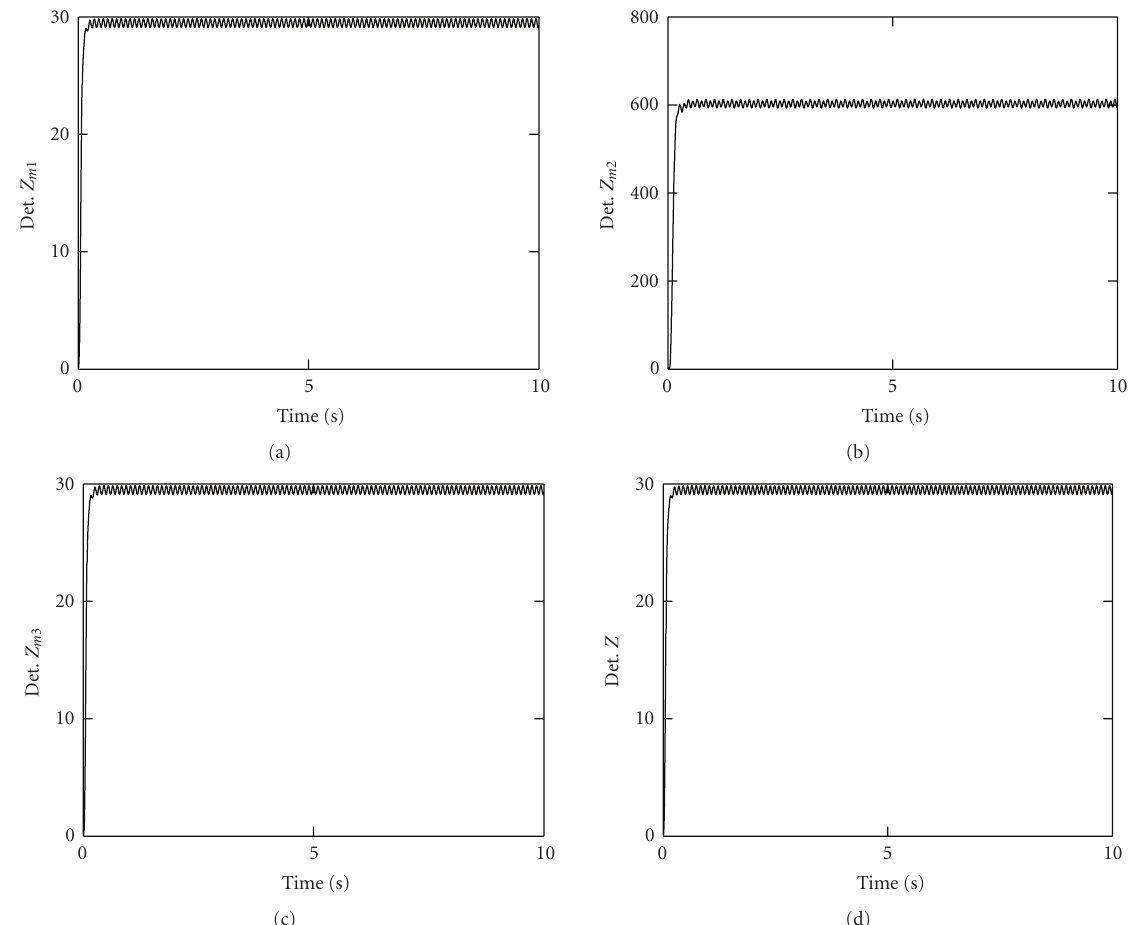
Figure 7: Time evolution of the determinants of the principal minors of the matrix Z ∈ R 4 × 4 Z m 1 , Z m 2 , Z m 3 , Z m 4 .